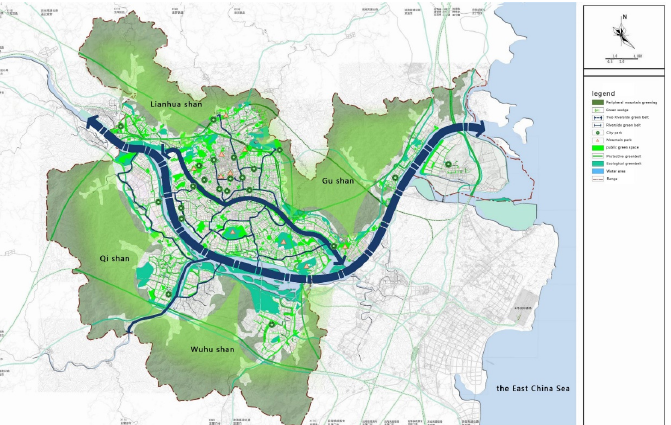
Figure 9. Planning diagram of green space system in Fuzhou city center